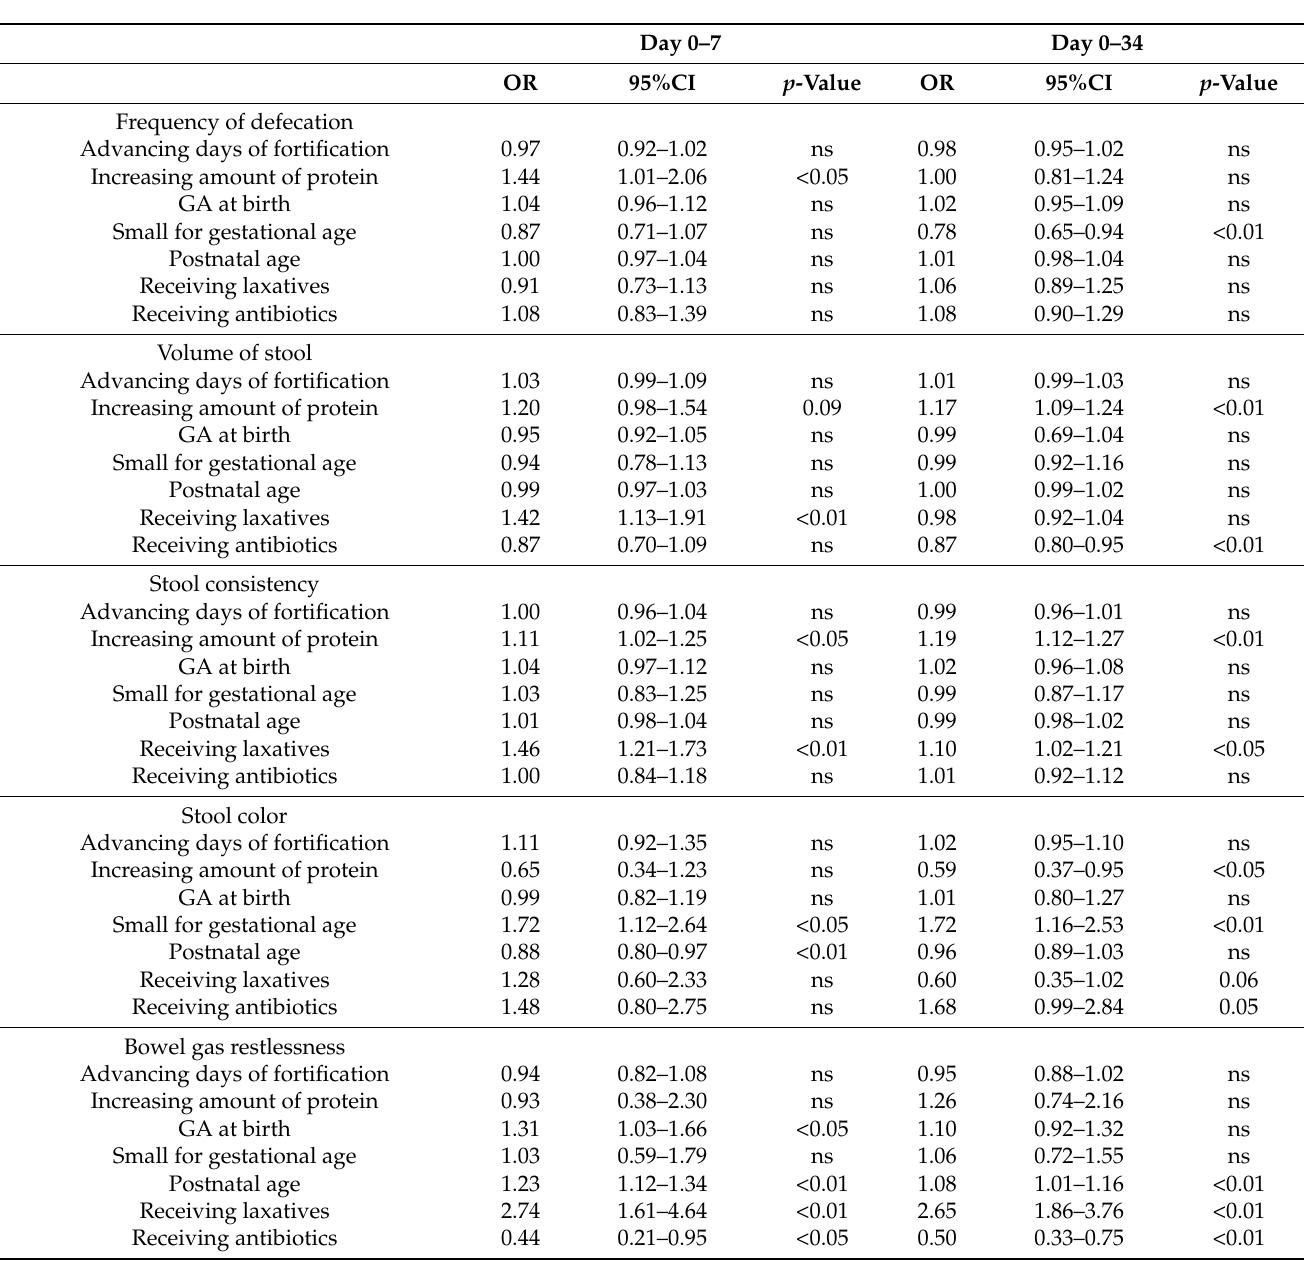
Table 3. The effect of Co-variates t on bowel habits and feeding intolerance. Numeric outcomes were analyzed using mixed effects linear regression for repeated data, including a random intercept for each infant. Dichotomous outcomes were analyzed using a mixed effects logistic regression model, and ordinal data using mixed effect ordinal logistic regression